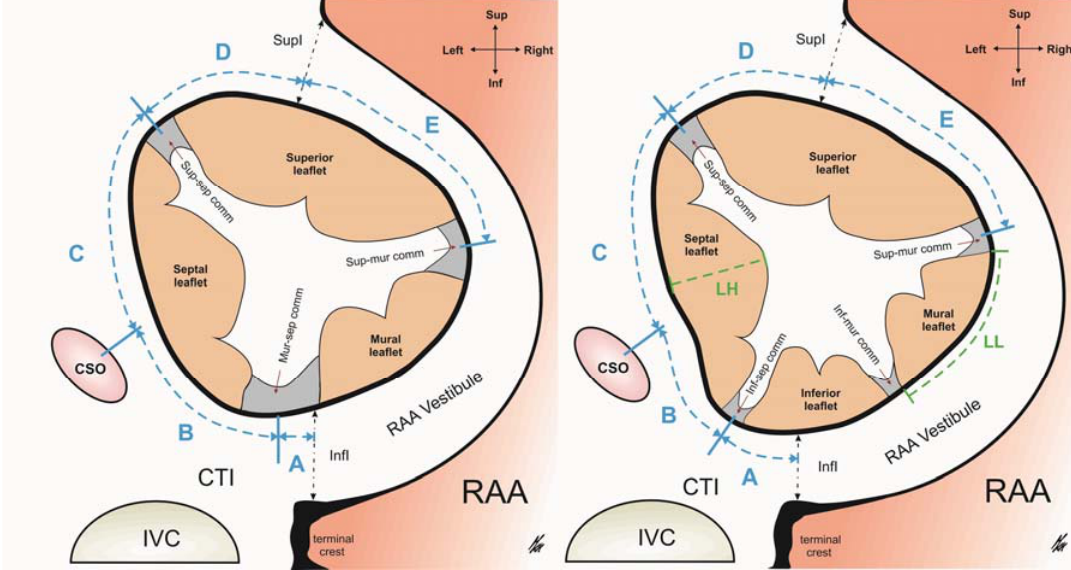
Figure 1. Schematic views of the RAV in 3-leaflet and 4-leaflet configurations. Performed measurements are marked (A—terminal crest to muro-septal or infero-septal commissure, B—coronary sinus ostium to supero-septal commissure, C—coronary sinus ostium to muro-septa or infero-septal commissure, D—right atrial appendage vestibule superior isthmus to the supero-septal commissure, and E—right atrial appendage vestibule superior isthmus to supero-mural commissure) with the relative proportions preserved. CSO—coronary sinus ostium, CTI—cavo-tricuspid isthmus, InfI—inferior isthmus, IVC—inferior vena cava, LH—leaflet height, LL—leaflet length, RAA—right atrial appendage, SupI—superior